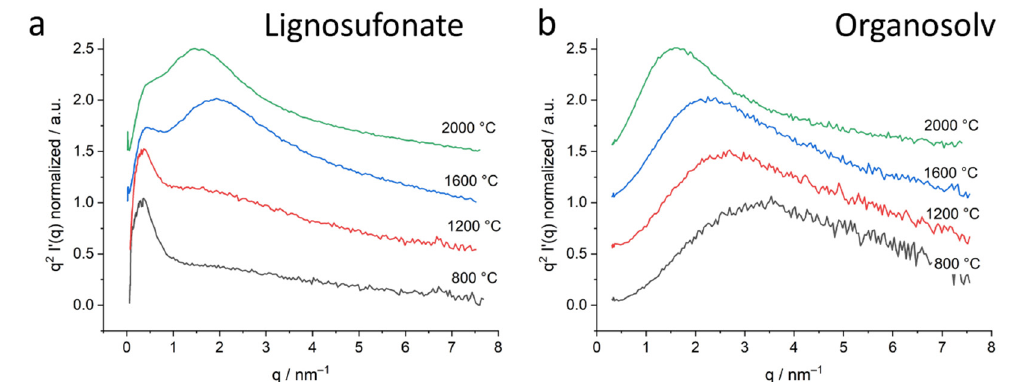
Figure 7. Kratky plots of the corrected small-angle X-ray scattering data of lignosulfonate ( a ) and organosolv ( b ) samples. Samples treated at 800 °C–2000 °C are displayed, the heat treatment temperatures are indicated in the graph. The curves are shifted along the Y -axis to enhance visibility.